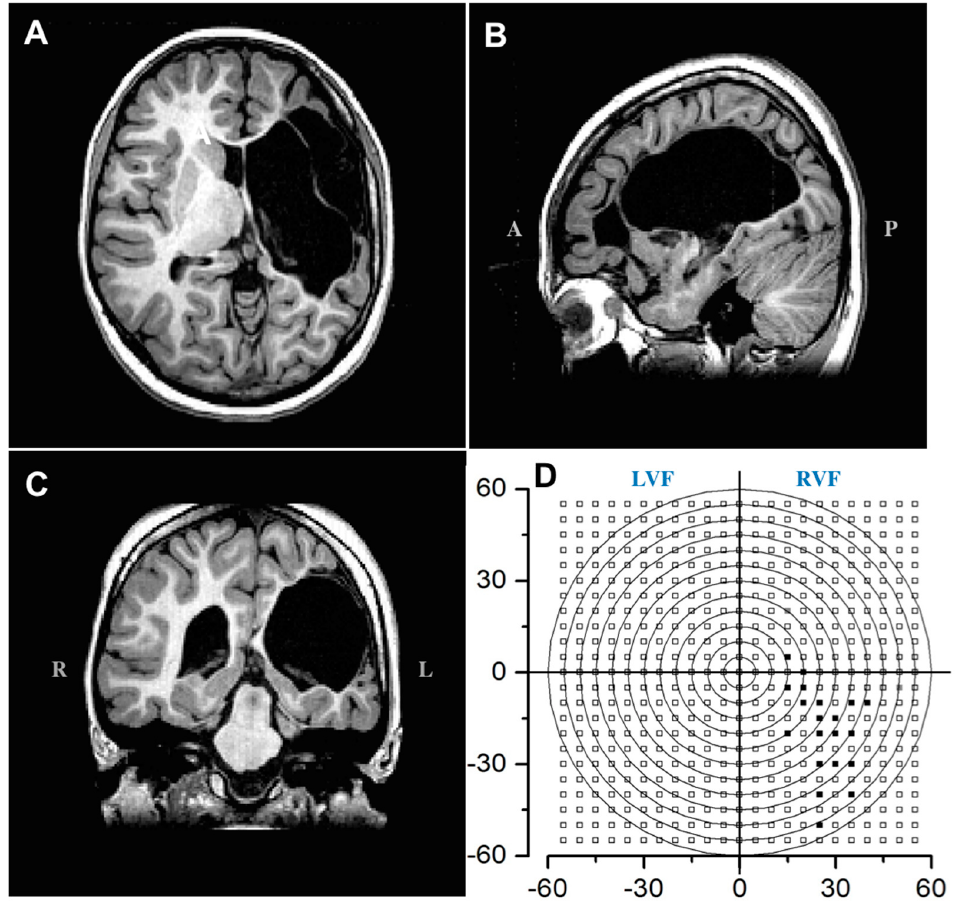
Figure 5. Structural T1-weighted MRI scan and visual field mapping of Patient IB . Sections showing the absence of LGN and optic radiations in the left hemisphere are displayed in ( A ) transverse, ( B ) sagittal (A-Anterior, P- Posterior), and ( C ) coronal planes (R- Right, L- Left). ( D ) Graphical reconstruction of visual field perimetry up to 60° of eccentricity. Visual field perimetry obtained with the KOWA AP 340, retaining 5° resolution of the perimetry. The contra-lateral right visual field has a very sparse scotoma in the lower field only after 15° of eccentricity. Open squares report successful detection at 15 and 17 dBs luminance levels; filled squares show an absence of detection at 0 dBs.